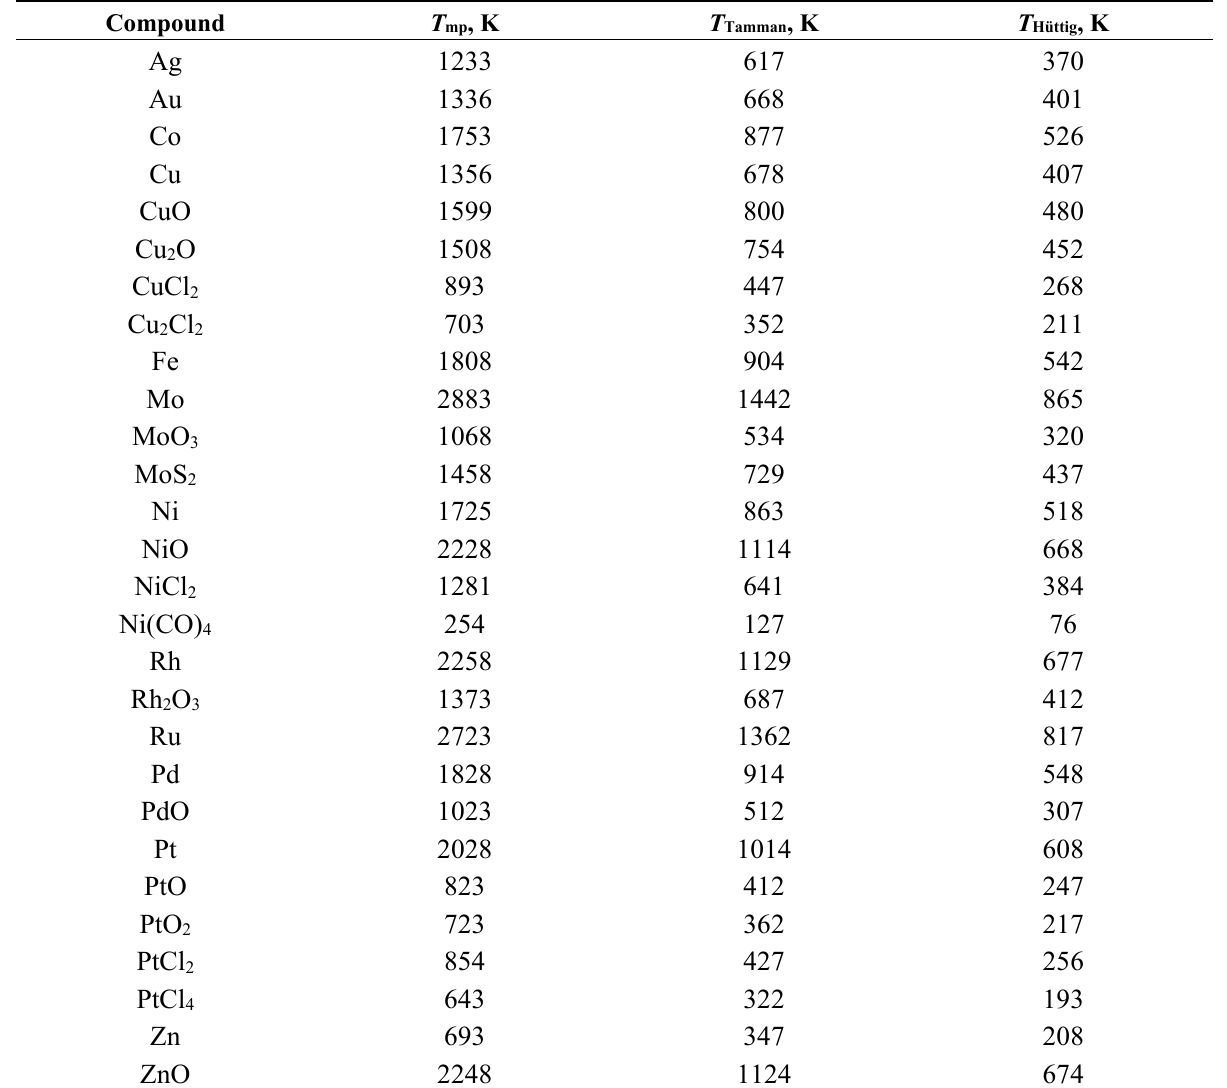
Table 9. Values of Melting and Tamman Temperatures ( °C) for Common Catalytic Metals and Their Compounds a